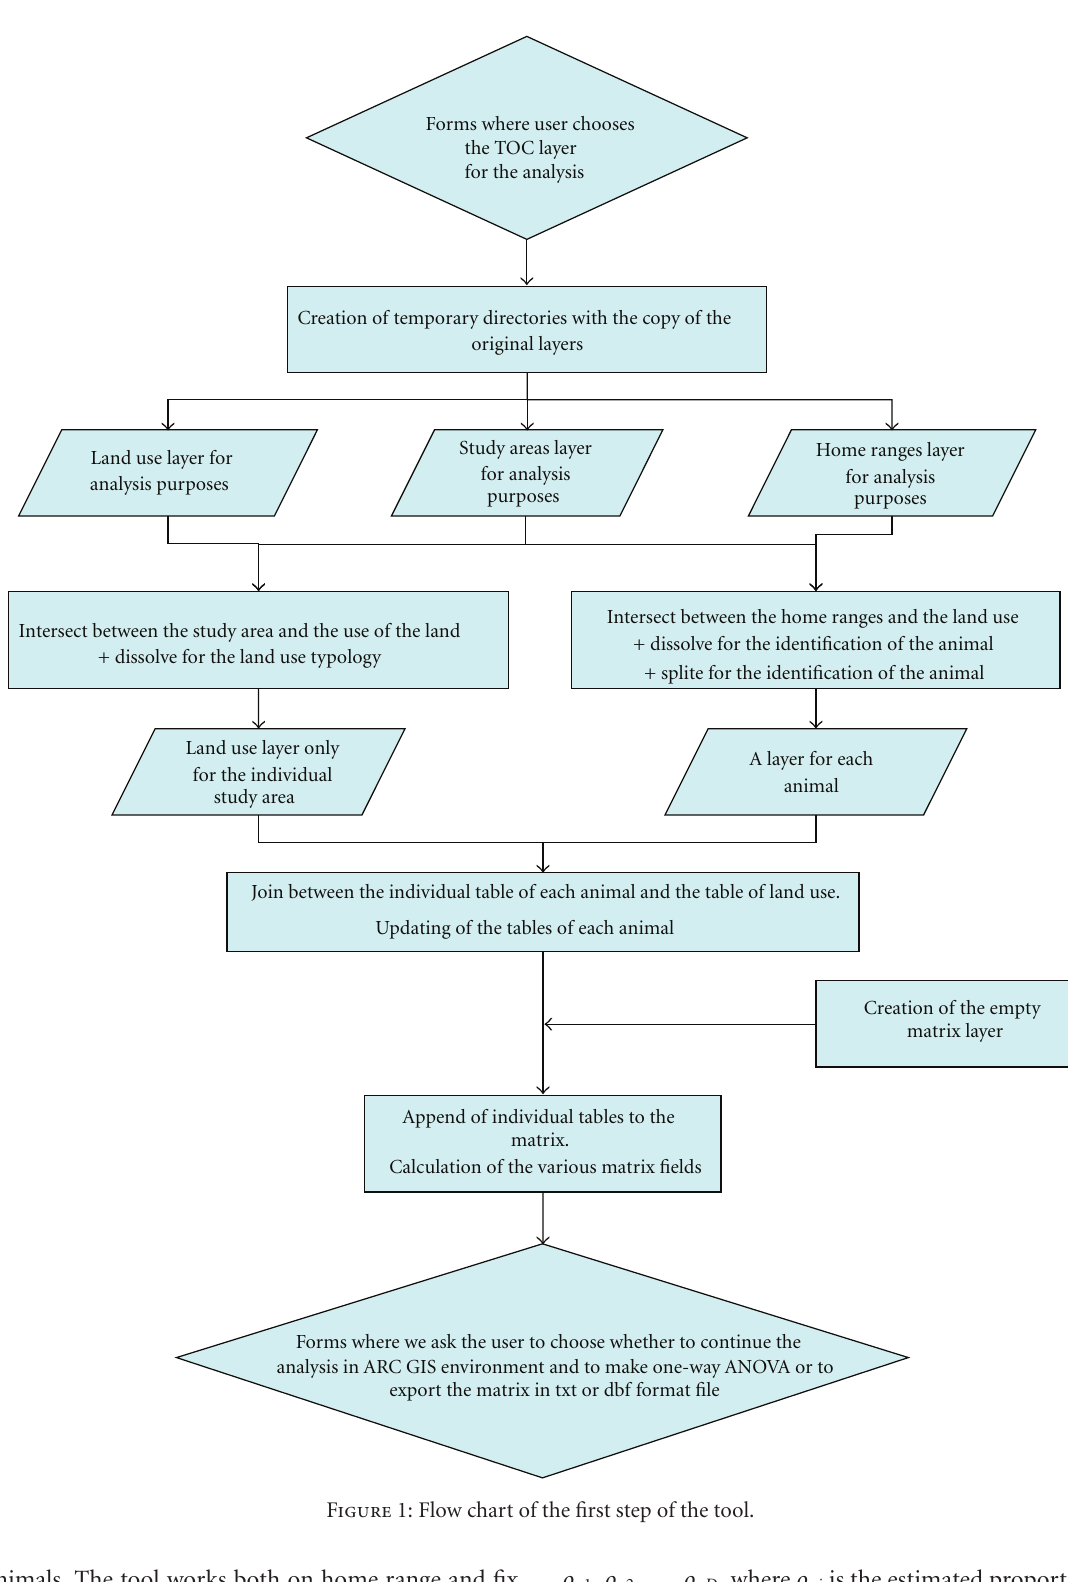
Figure 1: Flow chart of the first step of the